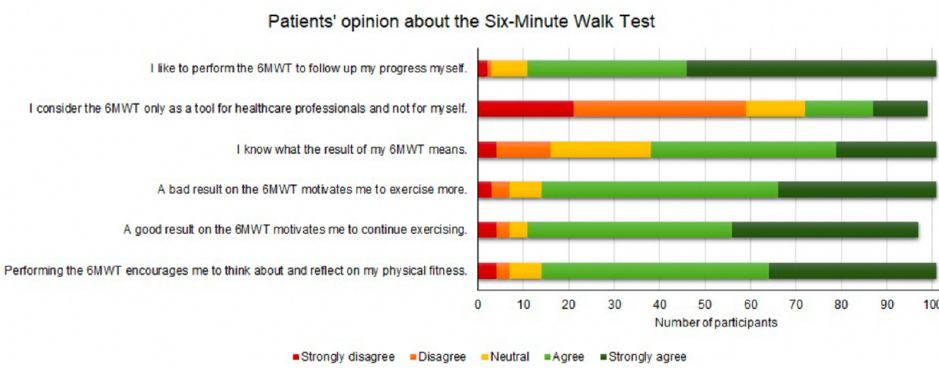
Figure 7. Cardiovascular disease patients’ opinion about the six-minute walk test (6MWT).